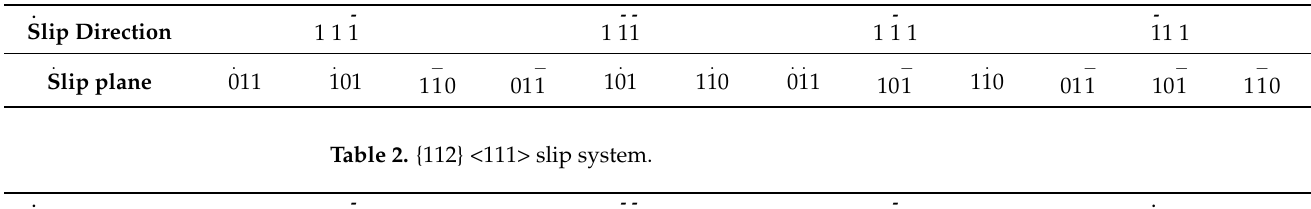
Figure 2. Body centroid cubic cell. Table 1. {110} <111> slip system.